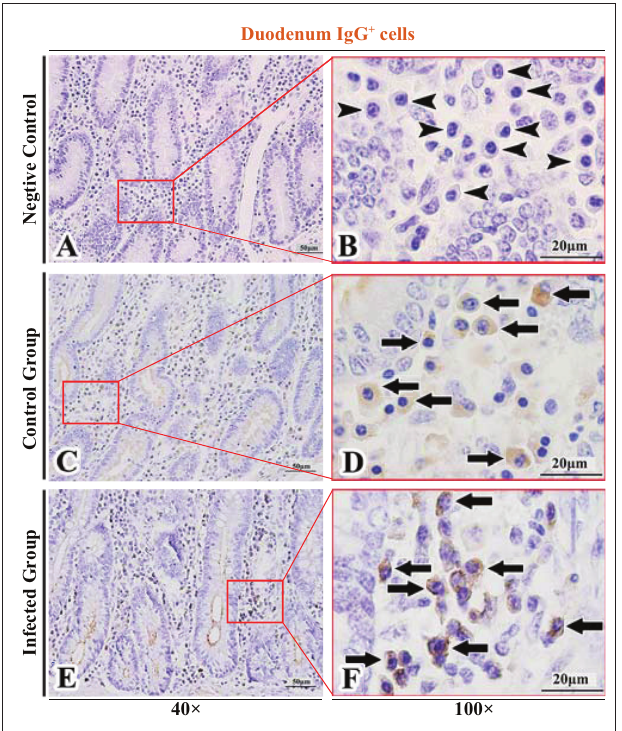
FIGURE 4 | Distribution of IgM + cells in sheep duodenum. (A,B) are negative controls; (C,D) are Control groups; (E,F) are Infected groups. Triangular arrows indicated plasma cells, arrows indicated IgM + cells, and the right image (Scale bar, 20 µ m) is a magnification from the part of the left image (Scale bar, 50 µ m).